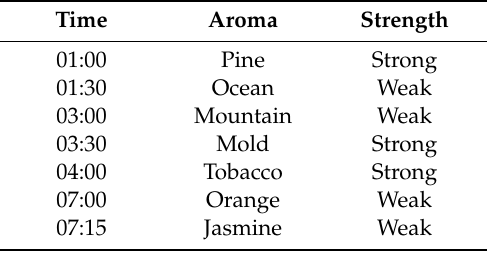
Table 1. Aromas Table 1. Aromas Schedule.